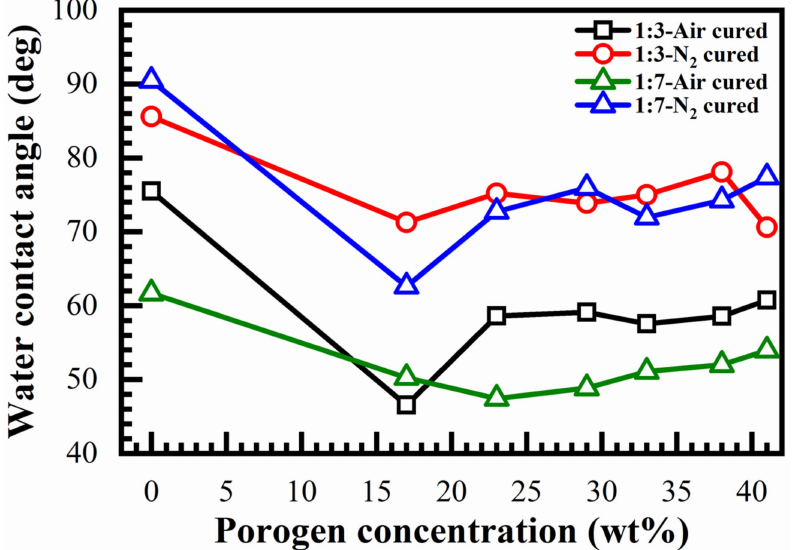
Figure 16. Influence of porogen loading on the water contact angle (WCA) of benzene bridge OSG films hard baked in the air (air-cured) and N 2 (N 2 -cured) for 1:3 and 1:7 benzene bridge ratio